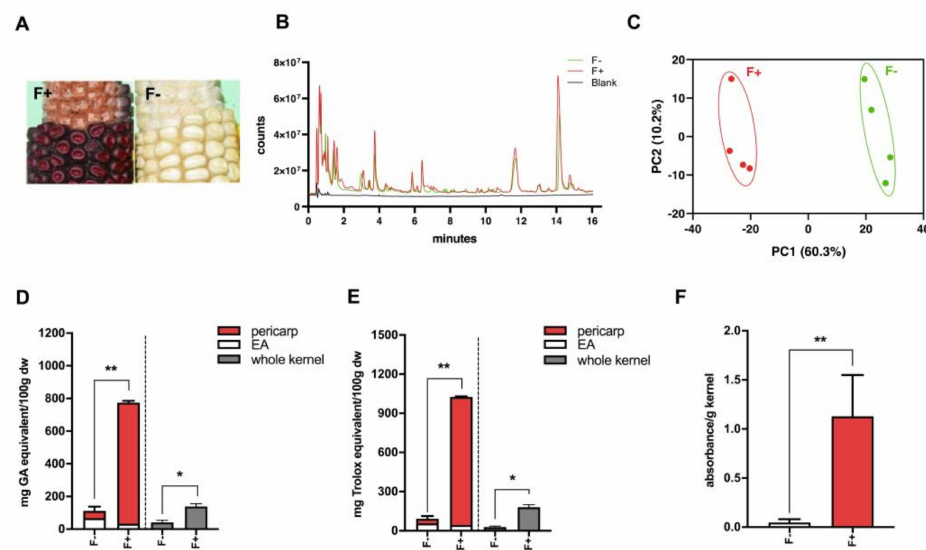
Figure 1. ( A ) Cob phenotype showing kernel pigmentation. Left panel shows red P1-rr (F + ) corn, and right panel shows white p1-ww (F − ) corn. F + accumulates flavan-4-ols displayed by red-colored kernels whereas F − lacks color pigmentation; ( B ) Global metabolomics overlay chromatogram of F + and F − methanol extracted fragments; ( C ) Principal coordinates analysis of the Euclidean distance matrix of F + and F − methanol extracted fragments; ( D ) Total phenolic content of F + and F − based on gallic acid standards assayed with Folin–Ciocalteu reagent; ( E ) Antioxidant activity of F + and F − based on Trolox standards assayed with 2,2-Diphenyl-1-picrylhydrazyl (DPPH); ( F ) Quantification of flavan-4-ols in F − and F + . EA (endosperm with aleurone layer). * p < 0.05, ** p < 0.01, two-tailed Student’s t